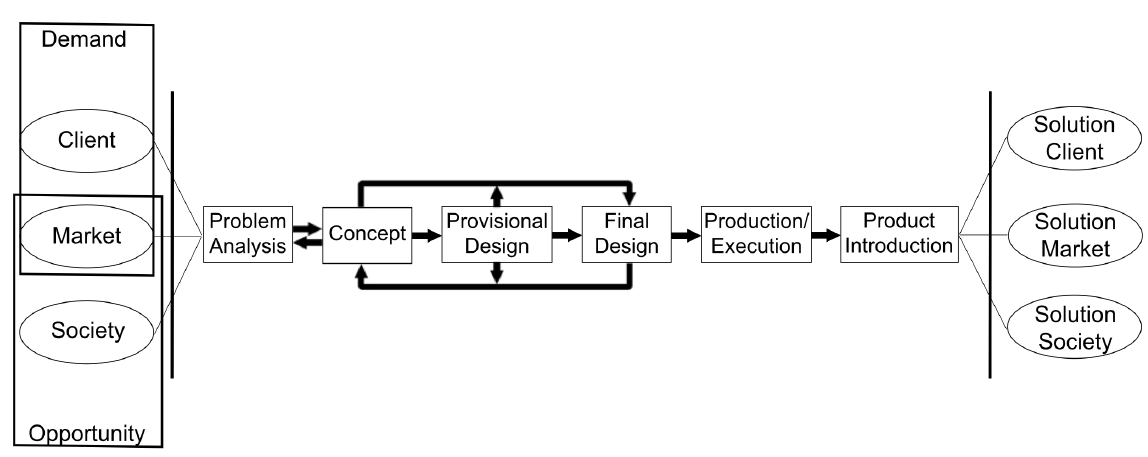
Fig. 1. Process model characteristic for product or service development in the CIs